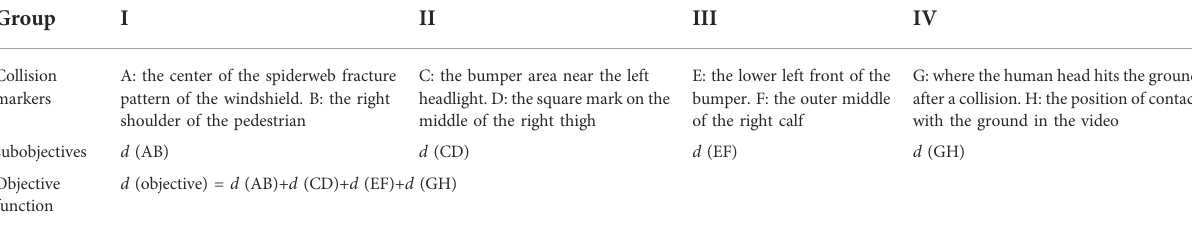
TABLE 2 Setting of four pairs of collision marker points and objective function. Group Collision